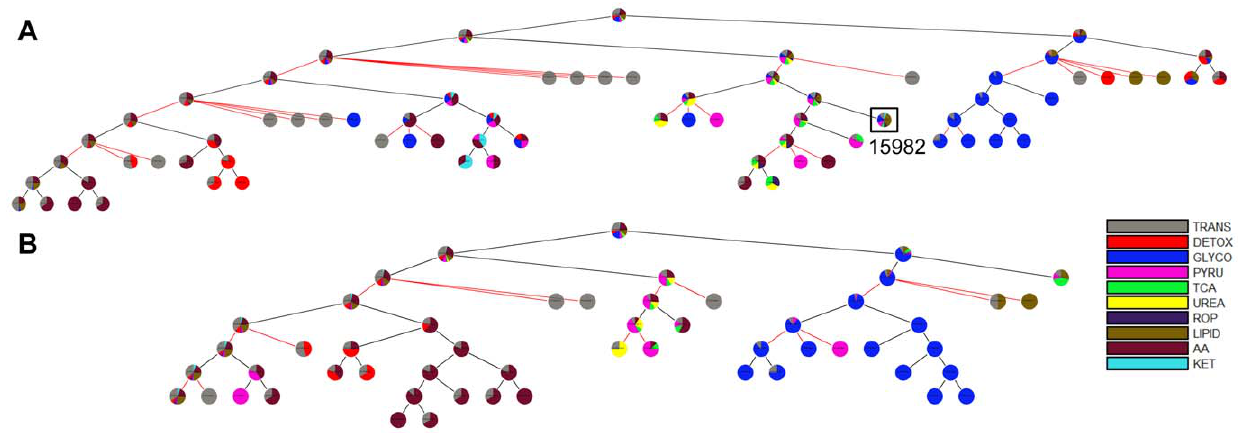
Figure 7. ShReD partitions of modified hepatocyte metabolic models. (A) Metabolic network with cofactors, but no regulatory edges. The boxed module (ID: 15982) contains pyruvate kinase. (B) Metabolic network with regulatory edges, but no cofactors. Note the absence of a redox module coupling detoxification reactions with lipid synthesis.